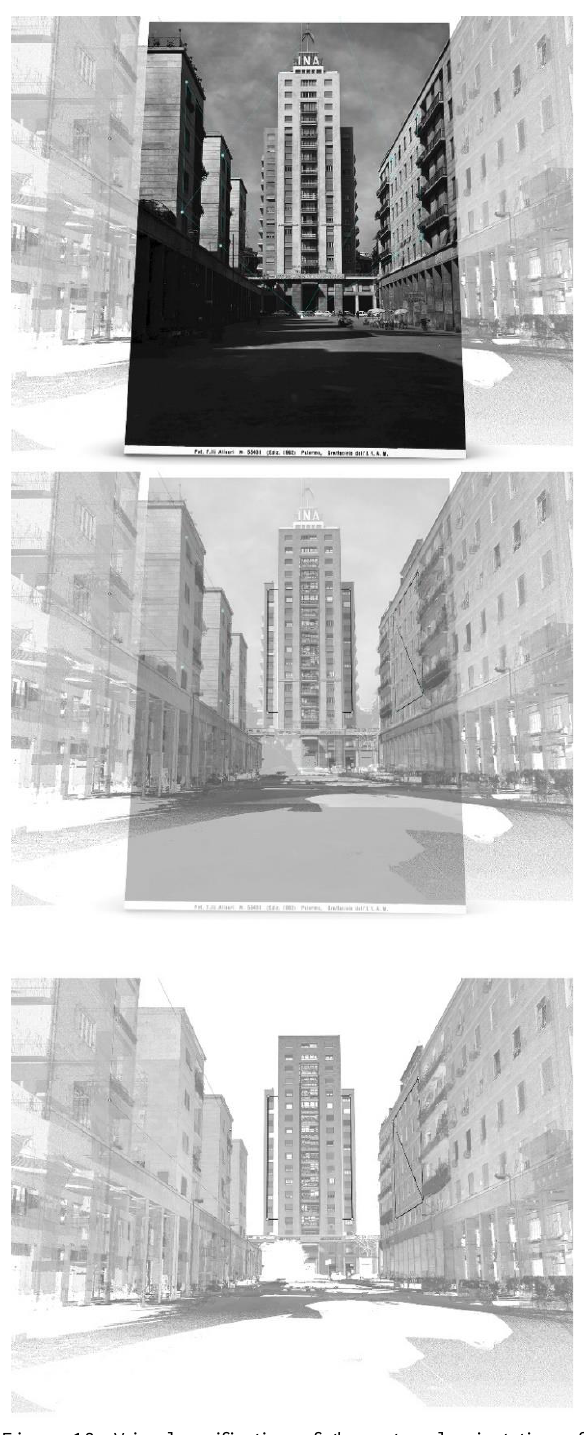
Figure 18: Visual verification of the external orientation of Alinari’s